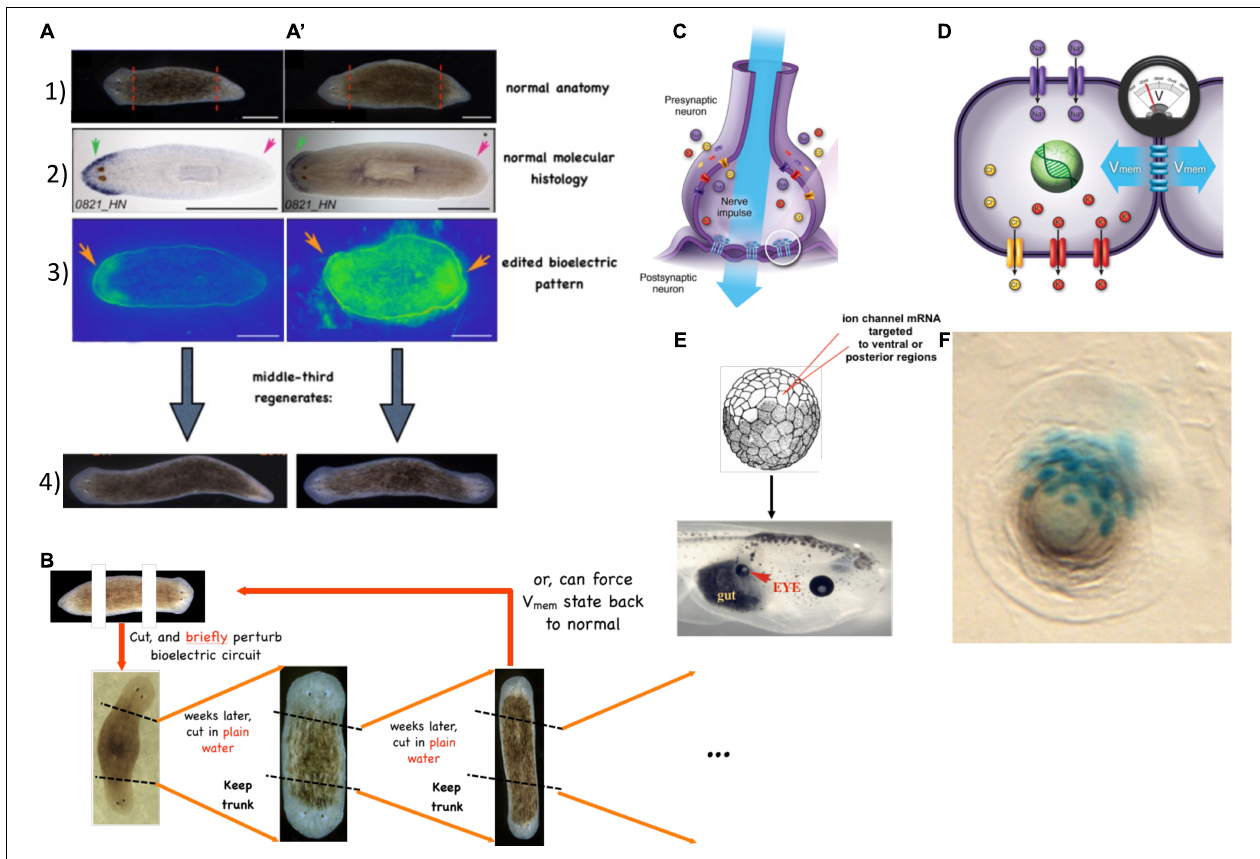
FIGURE 7 | Bioelectrical pattern memories. Planarian fragments reliably regenerate whatever is missing, and stop when a correct worm is complete. Normal planaria (A) have 1 head and 1 tail (A-1) , expression of anterior genes in the head (A-2) , and a standing pattern of resting potential that depolarized on the end that should make a head [ (A-3) , revealed by voltage-reporting fluorescent dye, depolarized region marked with orange arrowhead]. When a middle portion is amputated, it regenerates to a correct 1-headed worm (A-4) . It is possible to edit the information structure which encodes the target morphology (shape to which the fragments will regenerate). In worms that are anatomically normal (A (cid:48) -1) , with normal gene expression (A (cid:48) -2) , their bioelectric pattern can be altered in place [ (A (cid:48) -3) , orange arrowheads mark the two depolarized ends] using ion channel-targeting drugs or RNAi. The result, after injury, will be a fully viable 2-headed worm (A (cid:48) -4) . Importantly, the pattern shown in panel (A (cid:48) -3) is not a voltage map of the final 2-headed worm: it’s a map of a 1-headed animal before cutting, which already has the induced false memory indicating that a correct worm should have 2 heads. In other words, the bioelectrics can diverge from the current state—it is not simply a readout of what the anatomy is doing now, but an orthogonal information medium that is used to guide future changes of anatomy. This information is latent, only guiding the cellular collective’s anatomical homeostasis activity after injury. Thus it is also a basal example of counterfactual representation, referring to what